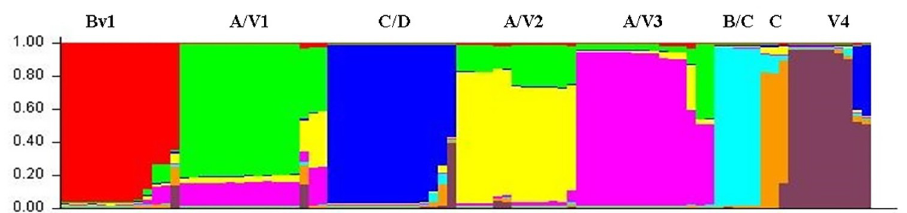
Fig 1. Bayesian cluster analysis of Amazon Peruvian samples. The predicted number of likely clusters ( K ) for samples collected in 2009–2010 (N = 88) was k = 8. Each color corresponds to a population classified by Structure v 2.3.4 and each individual isolate is represented by a vertical bar. The Y axis represents the estimated proportion of membership of an individual to each predicted population cluster.